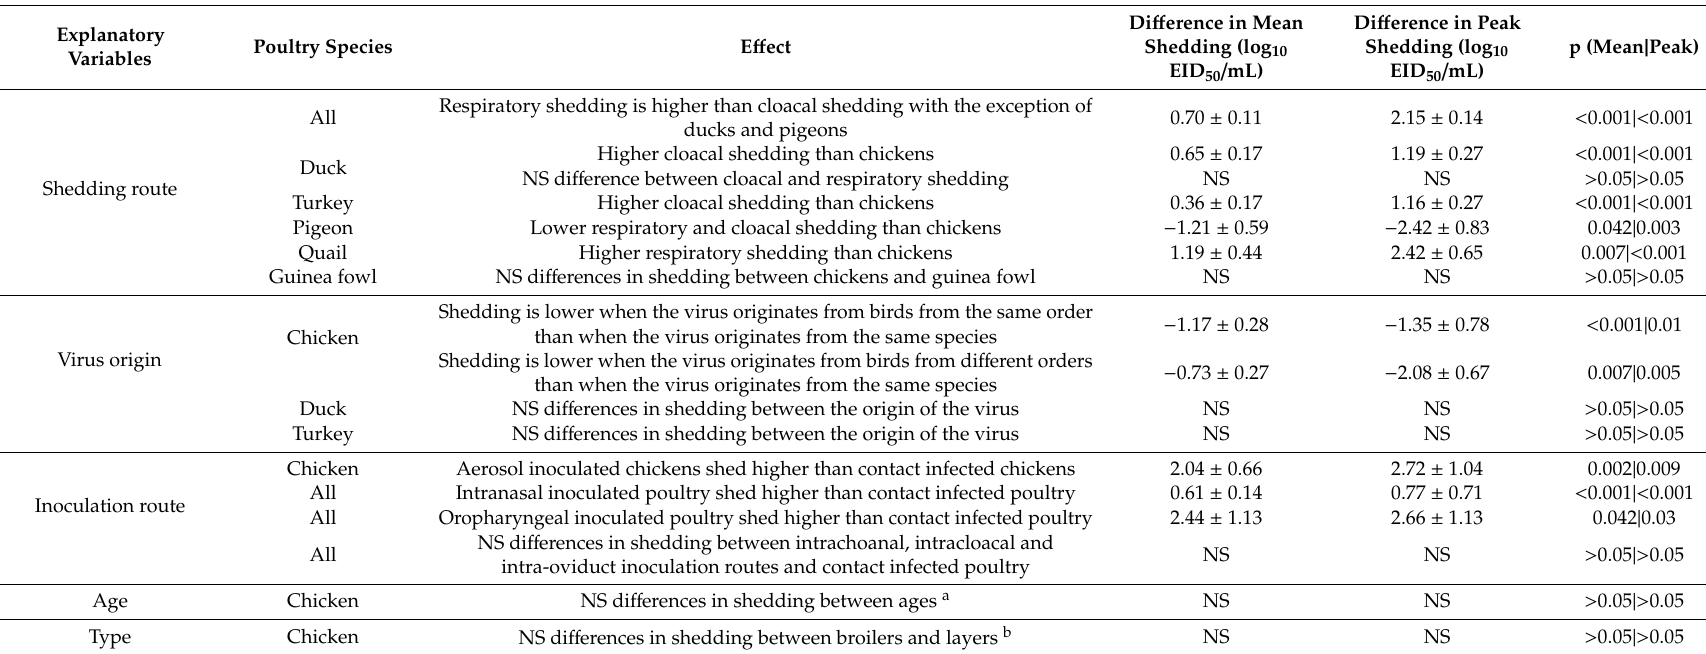
Table 3. Variables a ff ecting shedding (assessed as geometric mean shedding and peak shedding) levels in poultry infected with